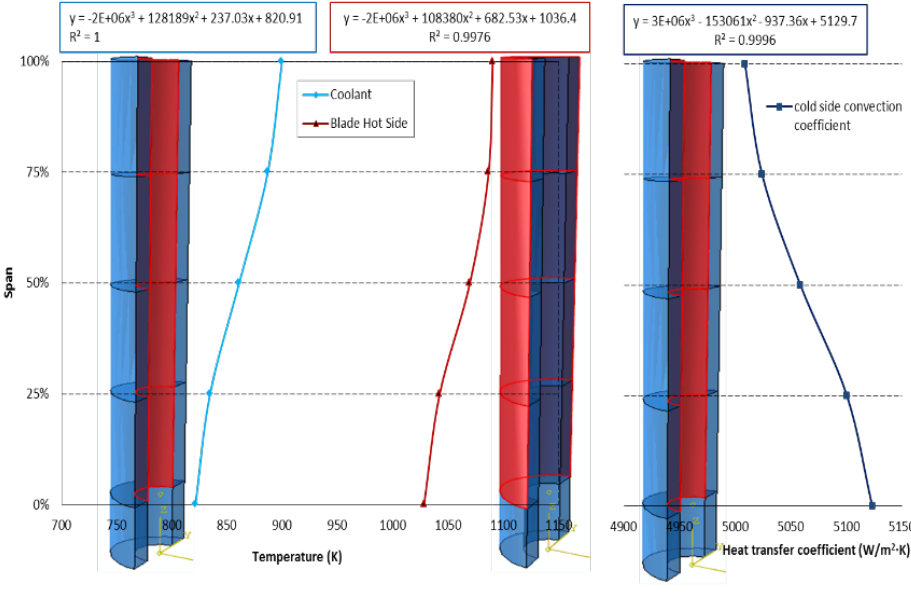
Figure 6: FEA hot and cold sides with thermal boundary